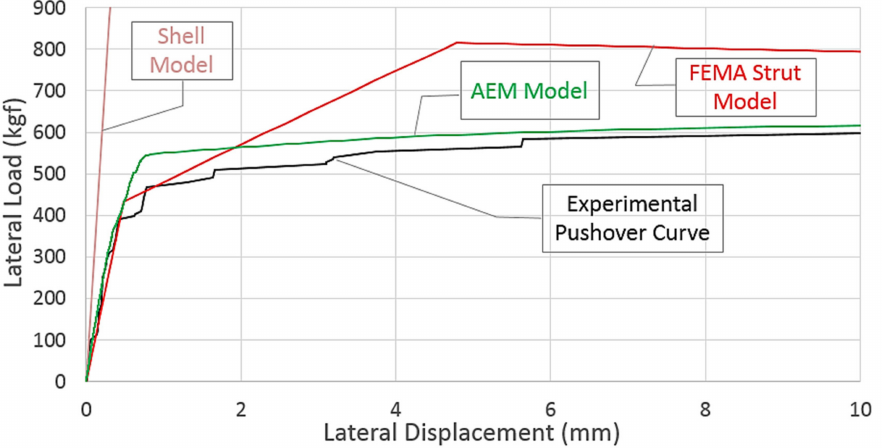
Figure 15. Comparison of experimentally obtained and predicted base shear vs top displacement for scaled IFM wall.